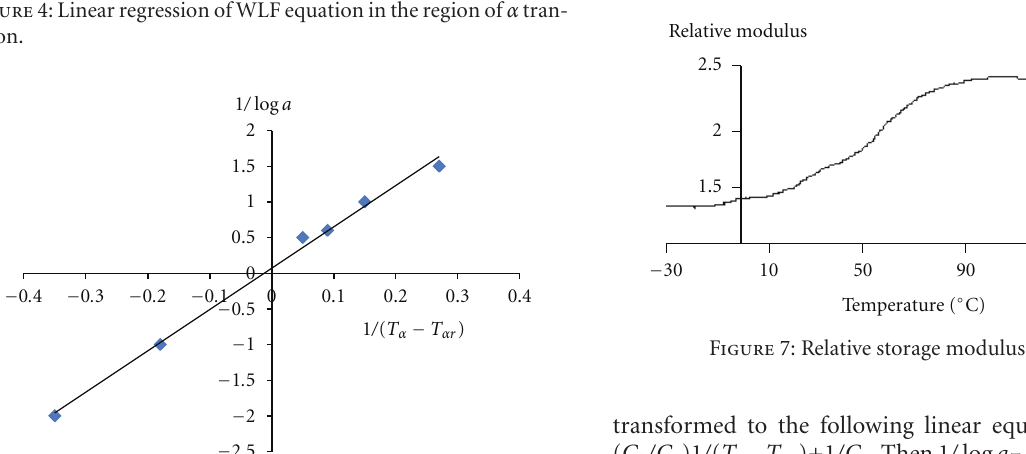
Figure 6: Storage modulus variation of unfilled (1) and mica-filled (2) polypropylene.